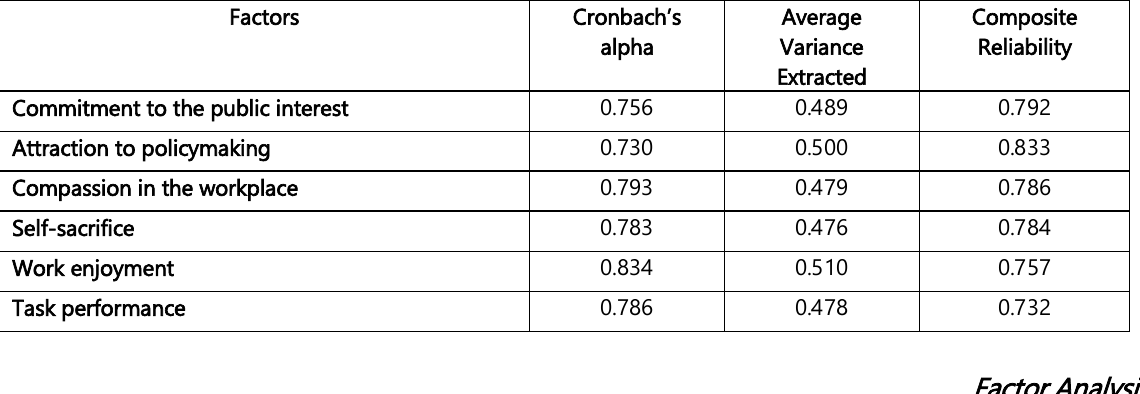
Table 2: Reliability Analysis (Source: Authors’ calculation)